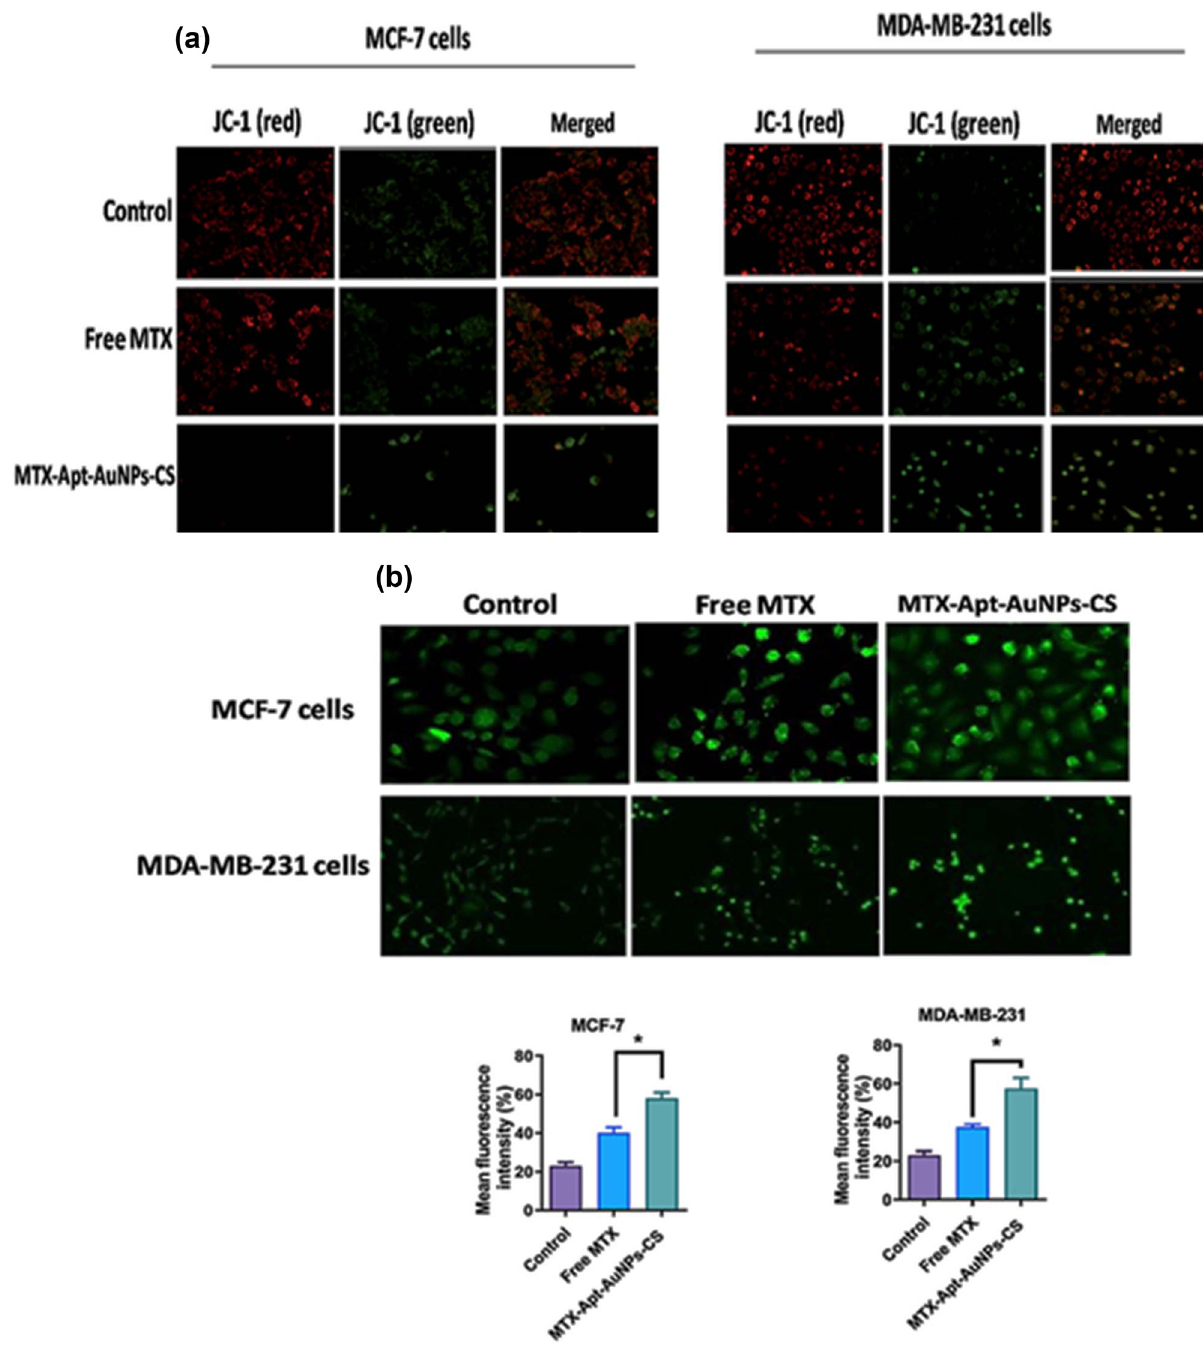
Figure 5: ( a ) Determination of MMP ( ΔΨ m ) disruption by JC - 1 dye and ( b ) ROS using fl uorescence microscopy ( 400 × magni fi cation ) . * p < 0.05 shows signi fi cant di ff